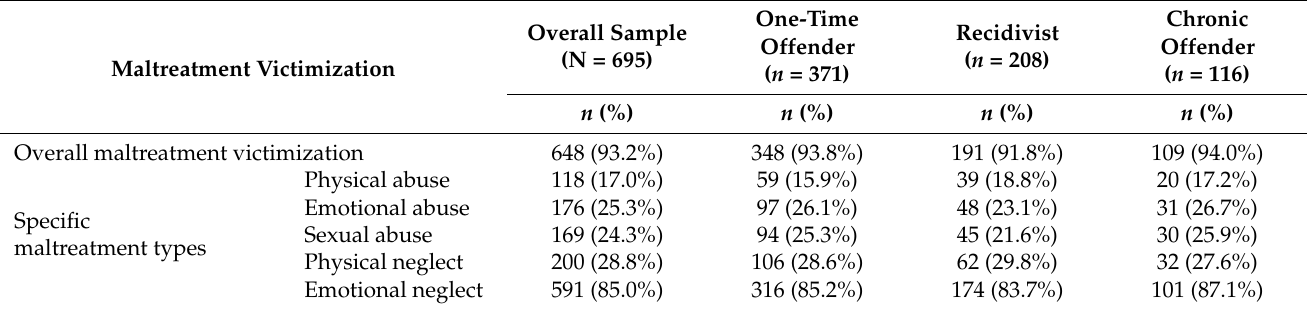
Table 2. Prevalence of child maltreatment victimization for the overall sample and various offender subgroups (based on cut-off